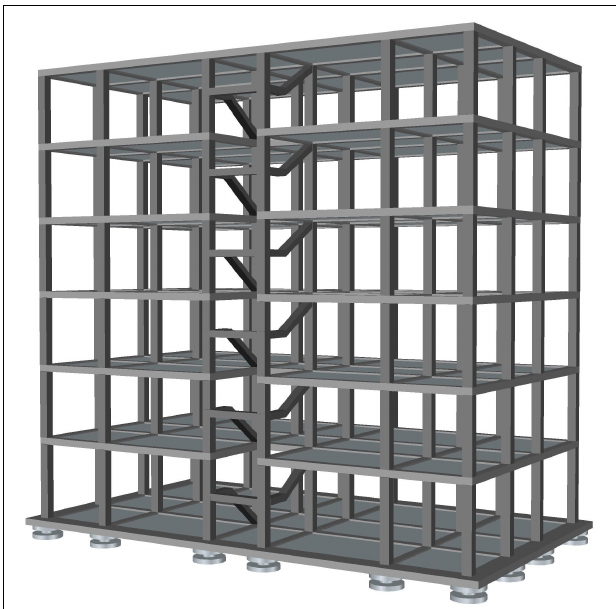
FIGURE 1 | Case study